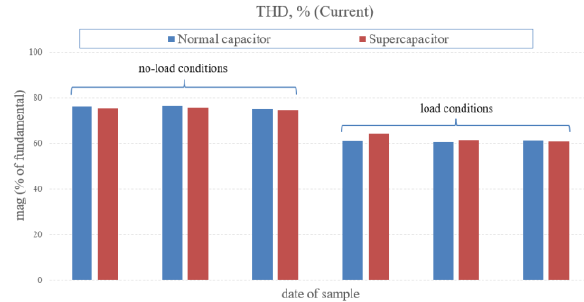
Figure 7. Influence of the converter load on the current THD